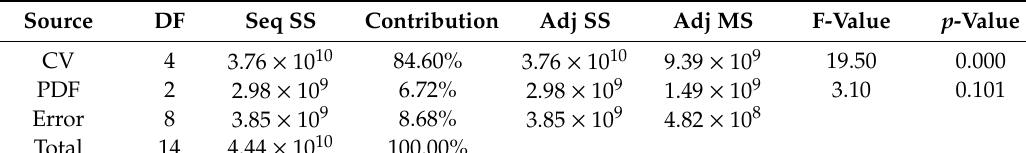
Table 7. ANOVA table for the ATC.